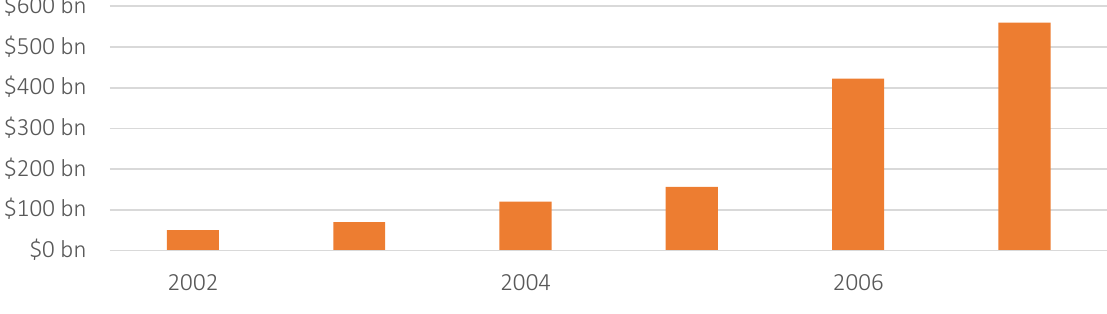
Figure 2. Value of leveraged buyouts in the US in $ billions